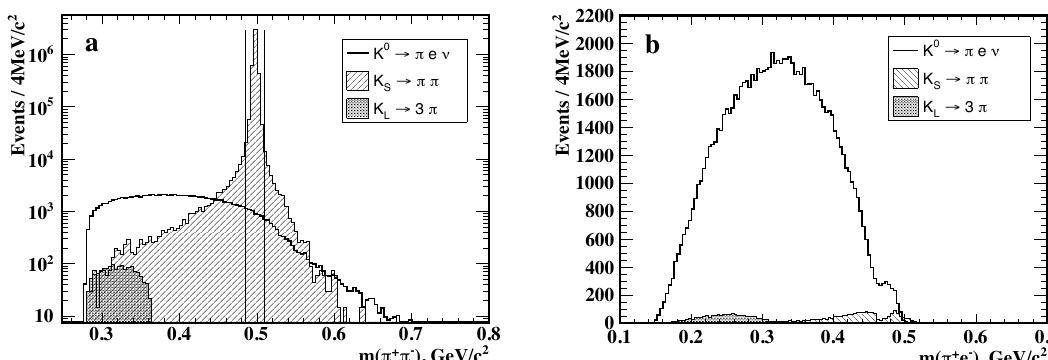
Figure 4 . (a) Distribution of the (cid:25) + (cid:25) (cid:0) invariant mass. The contributions from three processes are drawn. Here the pion mass is also assigned to an electron from K 0 ! (cid:25)e(cid:23) e decay. The vertical lines show the proposed K 0 veto. Applying this veto one can obtain the e(cid:25) invariant mass distribution S shown in the right (b) where hatched histograms represent the background